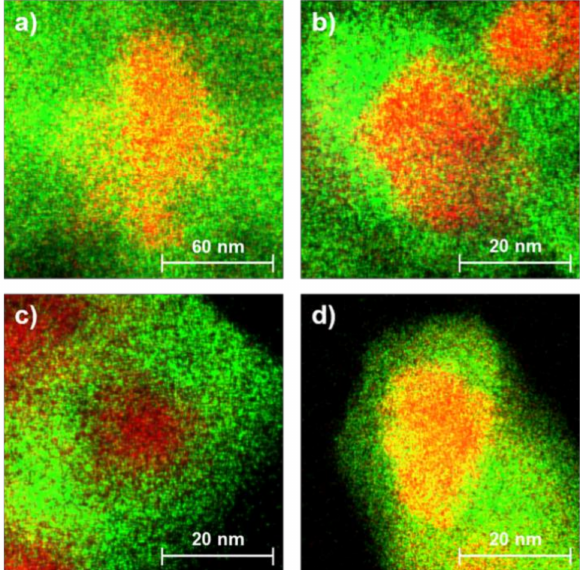
Figure 3. High-angle annular dark-field scanning transmission electron microscopy (HAADF-STEM) mapping images of the prepared oxygen carriers. CeO 2 @LSF ( a ), NiO@LSF ( b ), Co 3 O 4 @LSF ( c ), and Co 3 O 4 -NiO@LSF ( d ). Green = La, Sr, and Fe; (Red = each core metal (Co in ( d )), Yellow = Ni in ( d )).